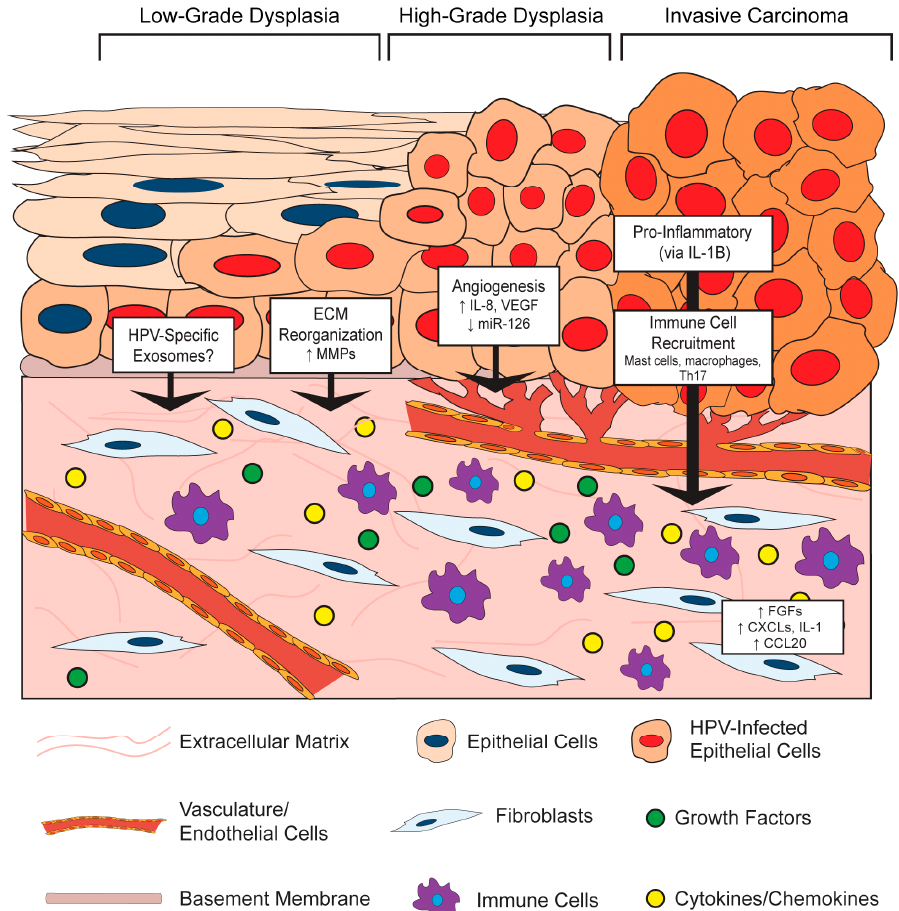
Figure 2. Effects of the HPV-positive epithelium on the stroma. The HPV-infected epithelium undergoes neoplastic progression from low-grade to high-grade dysplasia and eventually invasive carcinoma. Key epithelial-to-stromal communication events between the HPV-positive epithelium and the stroma, as well as the reported paracrine factors involved in these processes, are depicted. Large black arrows indicate events in the HPV-positive epithelium that affect the underlying stroma. Small black arrows represent an increase (up arrow) or decrease (down arrow) in the indicated factor. The location of signaling events within the process of neoplastic progression is not necessarily reflective of their temporal activities. ECM: extracellular matrix; CCL20: C-C Motif Chemokine Ligand 20; CXCLs: C-X-C Motif Chemokine Ligands; FGFs: Fibroblast growth factors; IL-1: Interleukin-1; IL-1B: Interleukin-1B; IL-8: Interleukin-8; miR-126: microRNA-126; MMP: matrix metalloproteinase; Th17: T helper 17 cells; VEGF: vascular endothelial growth factor.